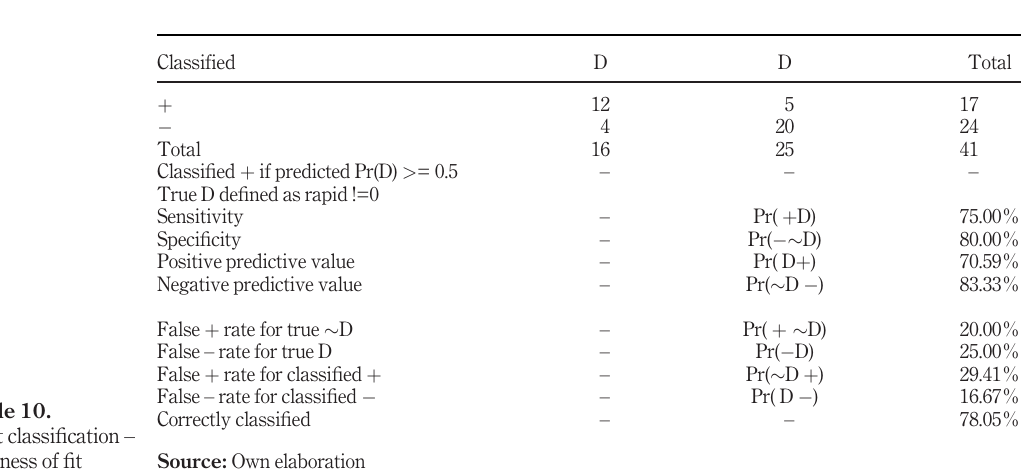
Table 10. Estat classi fi cation – goodness of fi